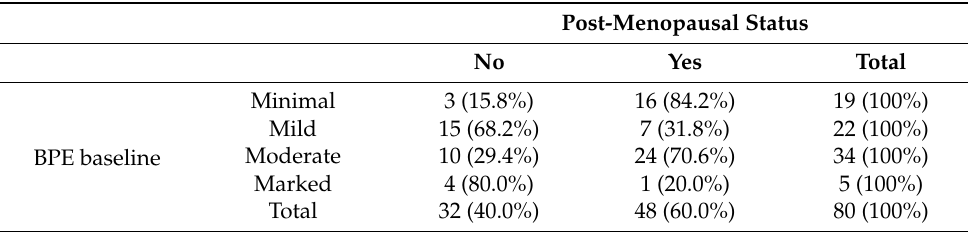
Table 3. Absolute frequency distribution (percentage) of baseline background parenchymal enhance- ment (BPE) of patients undergoing NAC compared to menopausal condition.